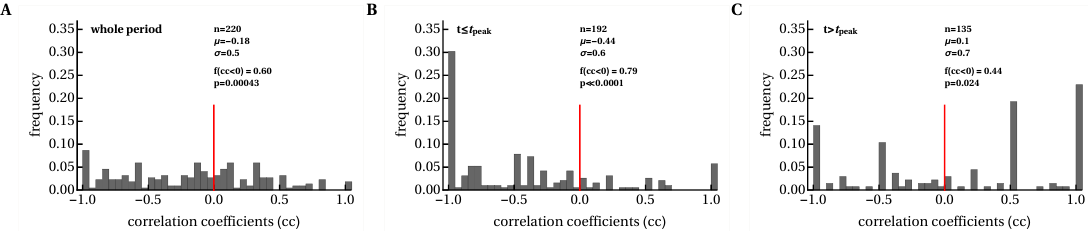
Figure 5. Expanding CD8 + T-cell responses were negatively correlated with viral load before T-cell numbers reached their peak values. We calculated Spearman’s correlation coefficients between longitudinal changes in viral load and epitope-specific CD8 + T-cell responses in each patient during the whole period ( A ), and before ( B ) and after ( C ) the peak of CD8 + T-cell response. The f ( cc < 0 ) value denotes the fraction of negative correlation coefficients ( cc ), and p values are indicated for the binomial test of equal distribution of positive and negative